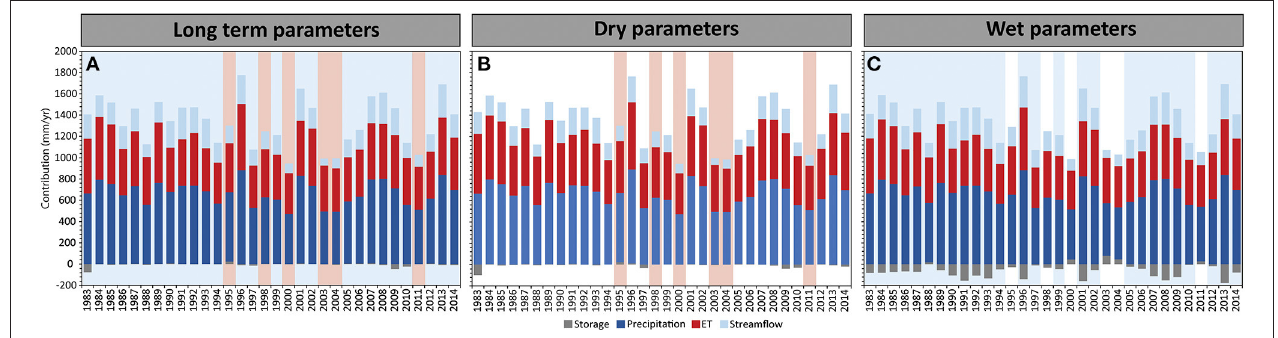
FIGURE 8 | The simulated water balance (mm/yr) for the periods 1984–2014 (including 1 year of initialization 1983 to show storage stabilization), which includes yearly precipitation (P: blue bar), evapotranspiration (ET: red bar), streamflow (Q: light blue bar) and storage ( 1 S: gray bar) using the (A) θ long − term , (B) θ dry , and (C) θ wet parameter sets. (B) θ long − term and θ wet differ with simulated storage (55 mm/yr), but was similar in terms of ET (12 mm/yr). θ long − term and θ dry were similar in terms of simulated storage (1 mm/yr) but differ in terms of simulated ET (27